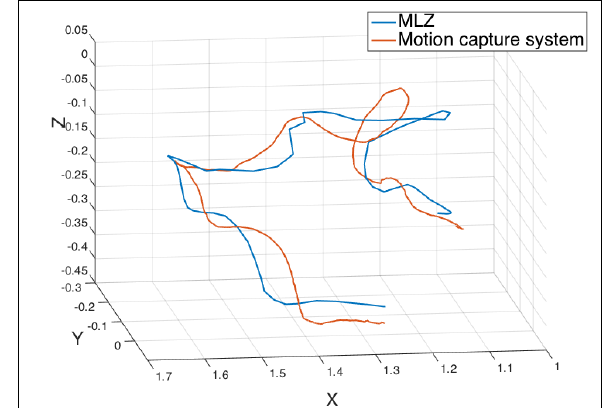
Figure 6. Flight trajectory recorded by the motion capture system and the trajectory estimated by the MLZ